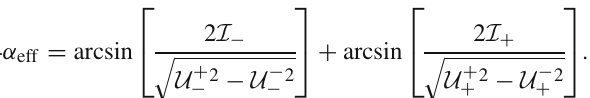
Simultaneously, the related phase between the conjugate